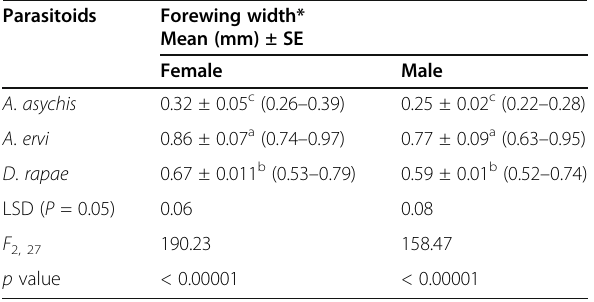
Table 3 Forewing width (mean ± S.E.) of the parasitoids parasitizing M . persicae